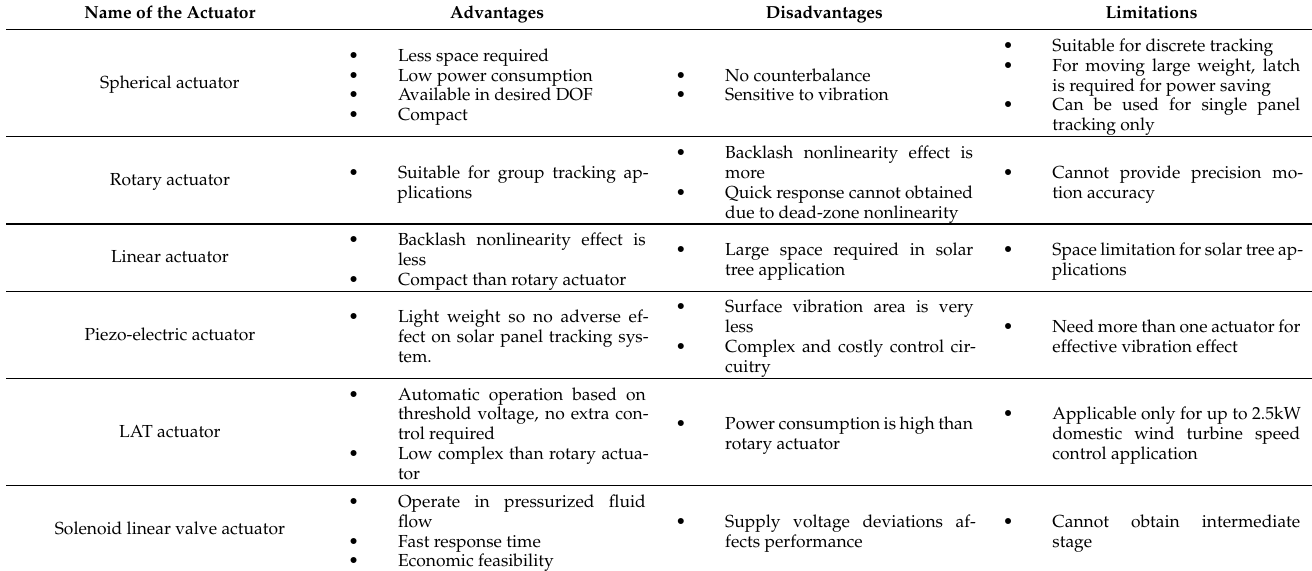
Table 7. Comparison of electric actuators used in the various renewable